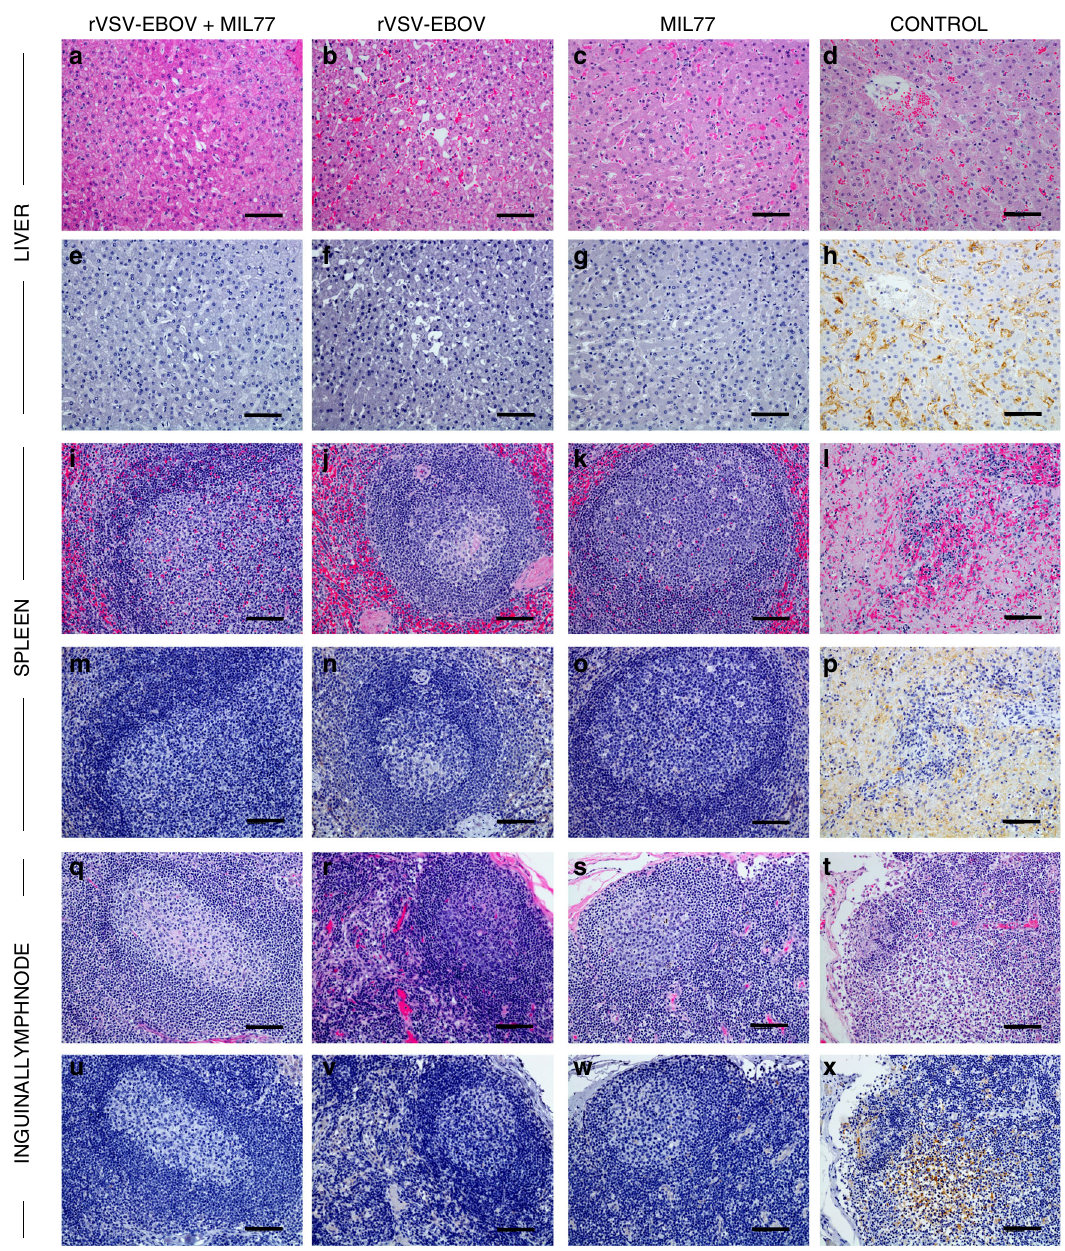
Fig. 2 Hematoxylin/eosin and immunohistochemical staining of tissues from EBOV-challenged rhesus macaques. Histological analysis was performed on tissues collected during necropsy from all animals in the present study as well as historical controls. Representative H&E-stained tissue specimens ( a – d , i – l , q – t ) and IHC antibody labeled tissue specimens ( e – h , m – p , u – x ) are depicted ING. LN = inguinal lymph node. For IHC images, EBOV antigen